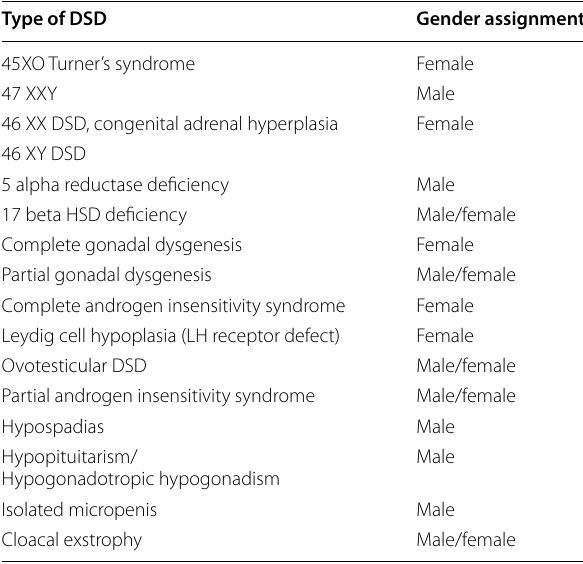
Table 8 The broad and general guidelines for gender assignment in DSD [18, 22, 23,